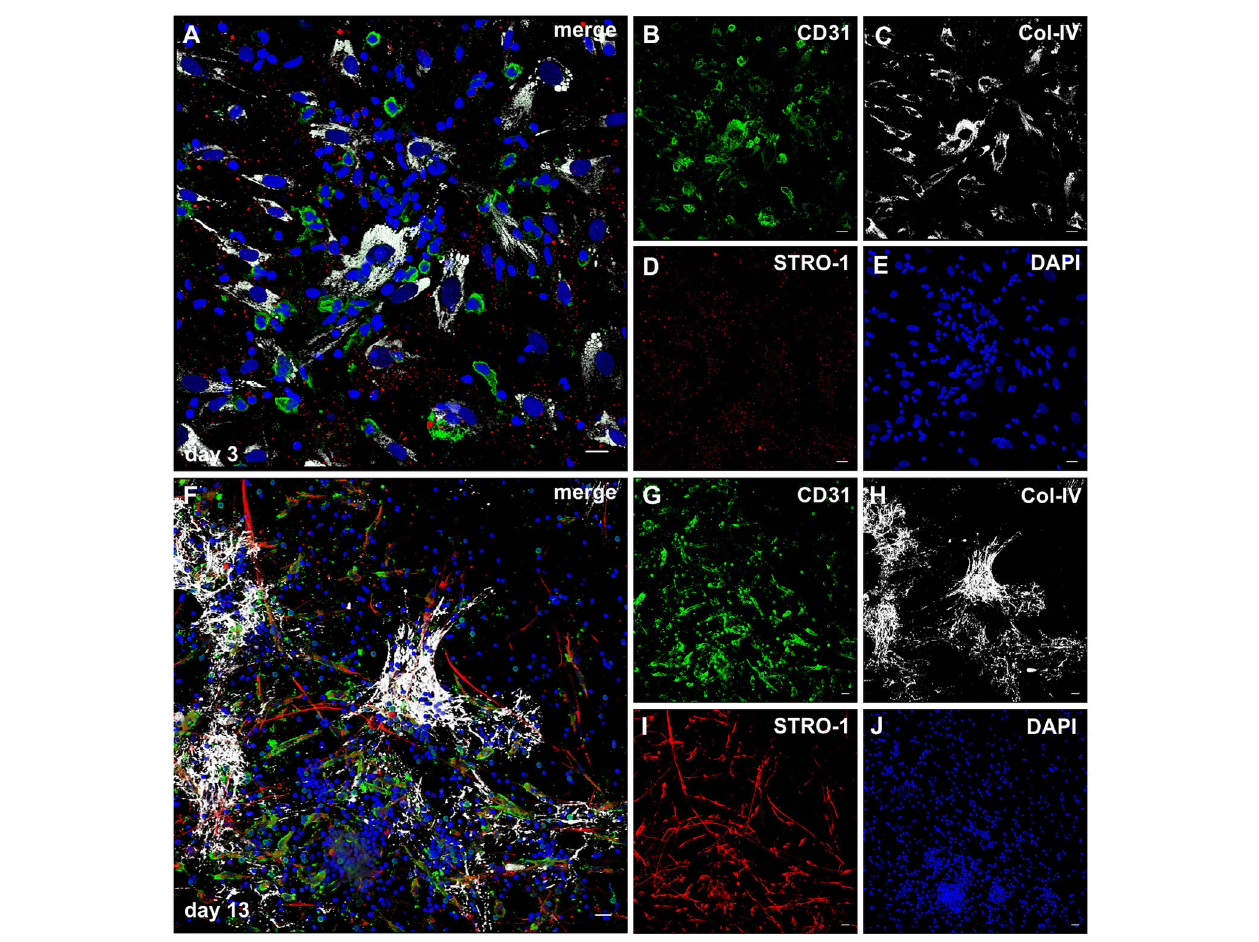
FIGURE 7 | STRO-1 expression during MSC-PBMC co-culture in 3D fibrin gels. (A) MSC-PBMC co-culture on day 3 showing close physical contact of mononuclear cells with Col-IV + STRO-1 + MSC. Some mononuclear cells are CD31 + . (C) MSC express Col-IV. (D) STRO-1 in MSC shows a granular staining pattern. (E) DAPI stain. (F) 3D MSC-PBMC co-culture on day 13 demonstrating elongated cells that co-express (G) CD31 and (I) STRO-1. CD31 + STRO-1 + cells are associated with (H) Col-IV positive cell clusters. Note that round CD31 + cells are STRO-1 − . STRO-1 + CD31 − MSC show long cell protrusions. (J) DAPI stain. (A–J) Representative CLSM images of MSC-PBMC co-cultures within 3D fibrin matrices. Scale bars, 20 µ